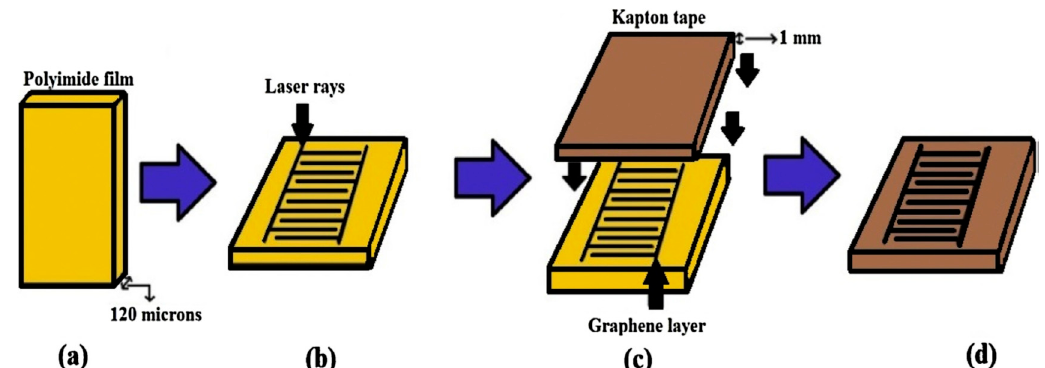
Figure 2. Schematic diagram of the steps of fabrication regarding the laser-induced graphene from polyimide films [27]. ( a ) The commercial polymers were ( b ) laser-induced to form graphene. ( c ) This graphene was transferred to Kapton tapes to form ( d ) the final